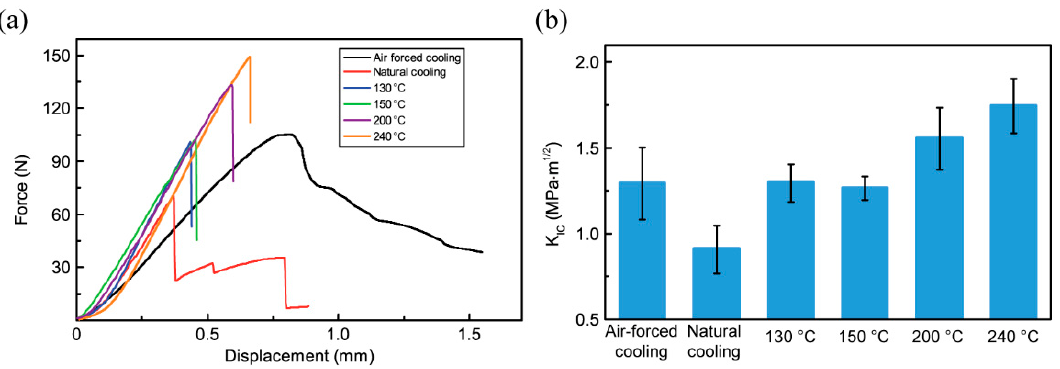
Figure 10. Fracture toughness of 3D-printed PPS compact tension samples: ( a ) The displacement and force curves; ( b ) the stress intensity factor K IC .